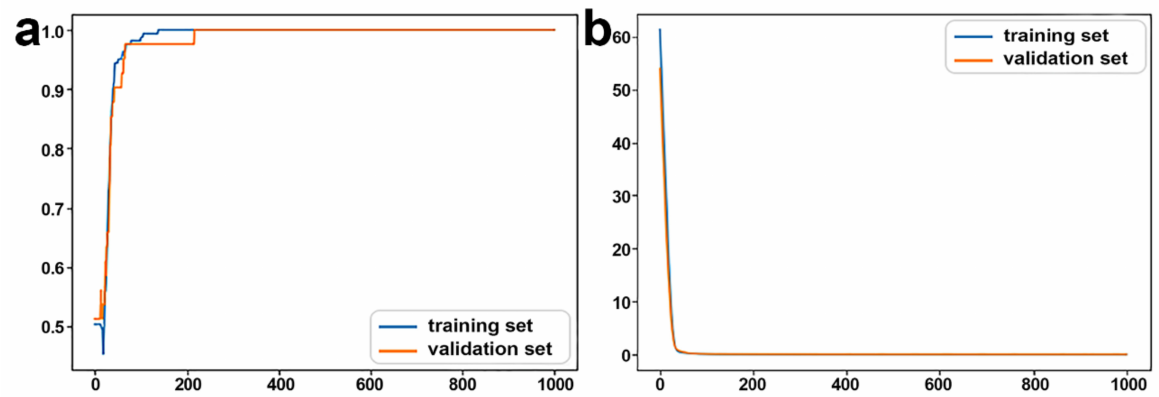
Figure 8. The potential ceRNA subnetwork with ceRNA regulatory and mRNA interaction relationships.